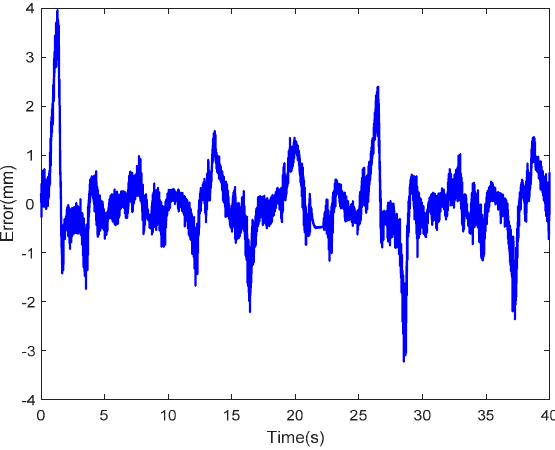
Figure 27. Results of the LSSVM-NARX model at random sinusoidal actuating voltage II. Figure 26. Results of the LSSVM ‐ NARX model at random sinusoidal actuating voltage II. Figure 26. Results of the LSSVM ‐ NARX model at random sinusoidal actuating voltage II. Figure 26. Results of the LSSVM ‐ NARX model at random sinusoidal actuating voltage II.